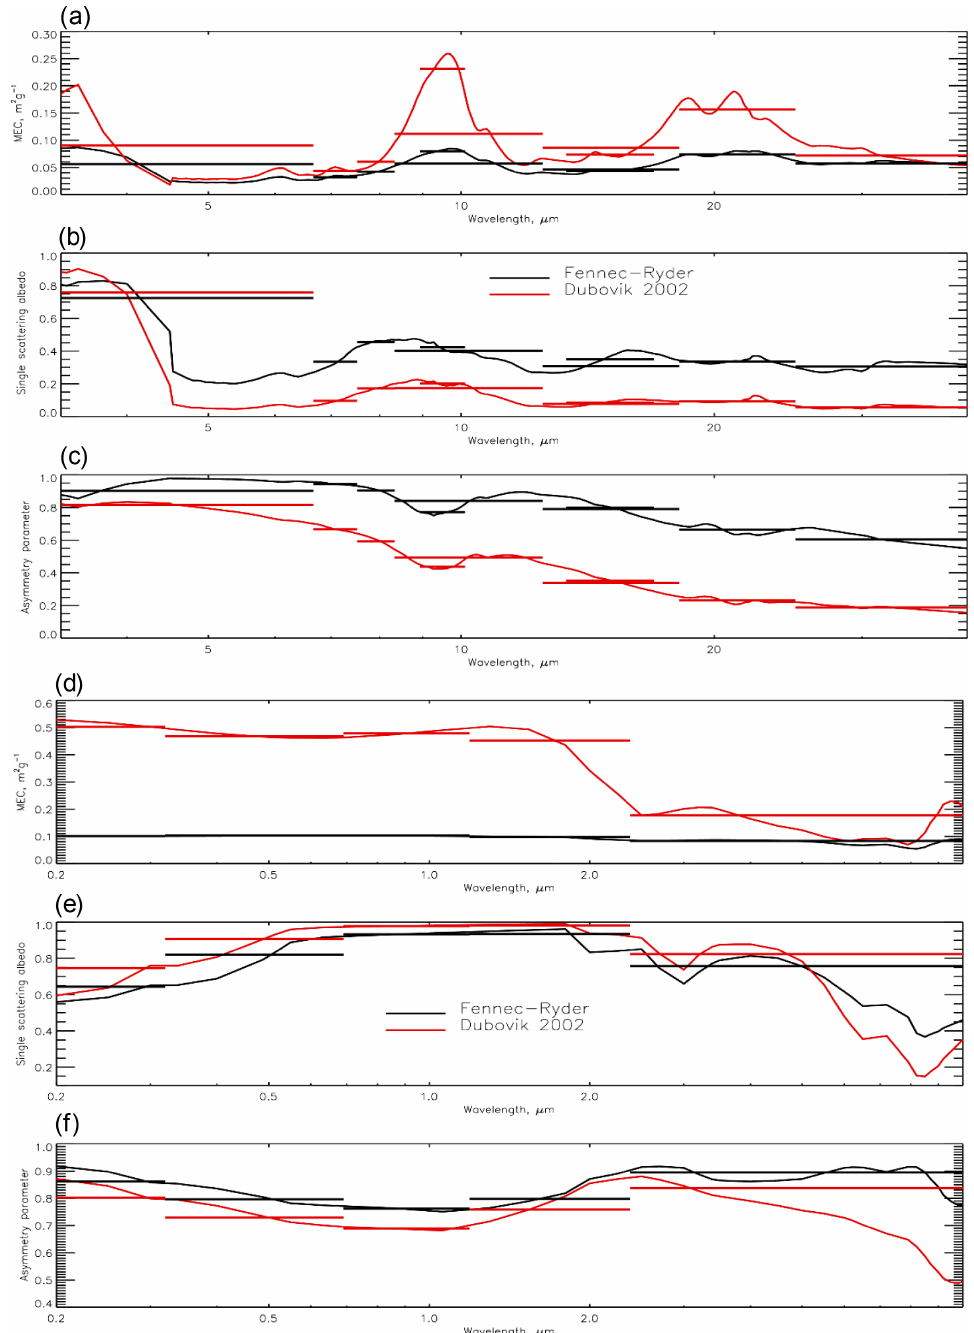
Figure 5. Wavelength dependence of optical properties of dust particle for longwave (a, b, c) and shortwave (d, e, f) . (a, d) Mass extinction coefficient, (b, e) single scattering albedo, and (c, f) asymmetry parameter. The continuous lines are the spectrally resolved optical properties, and the horizontal lines are the band-averaged data that are used in the RT